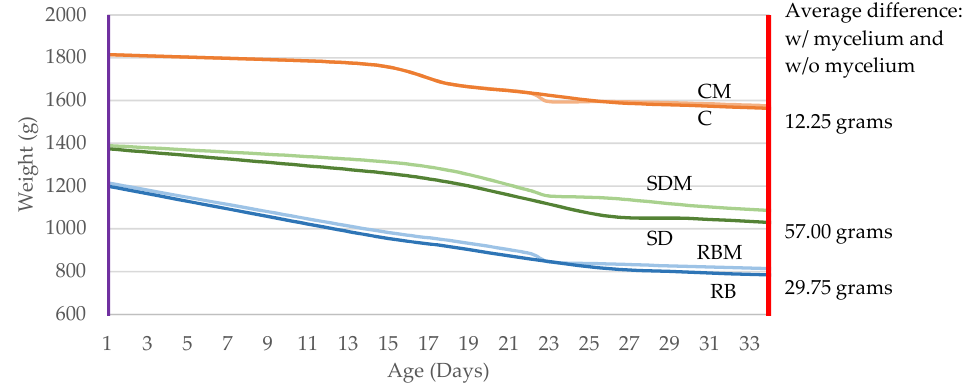
Figure 5. Estimated mycelium content is taken as the average difference of the weight between mycelium and non-mycelium bricks.